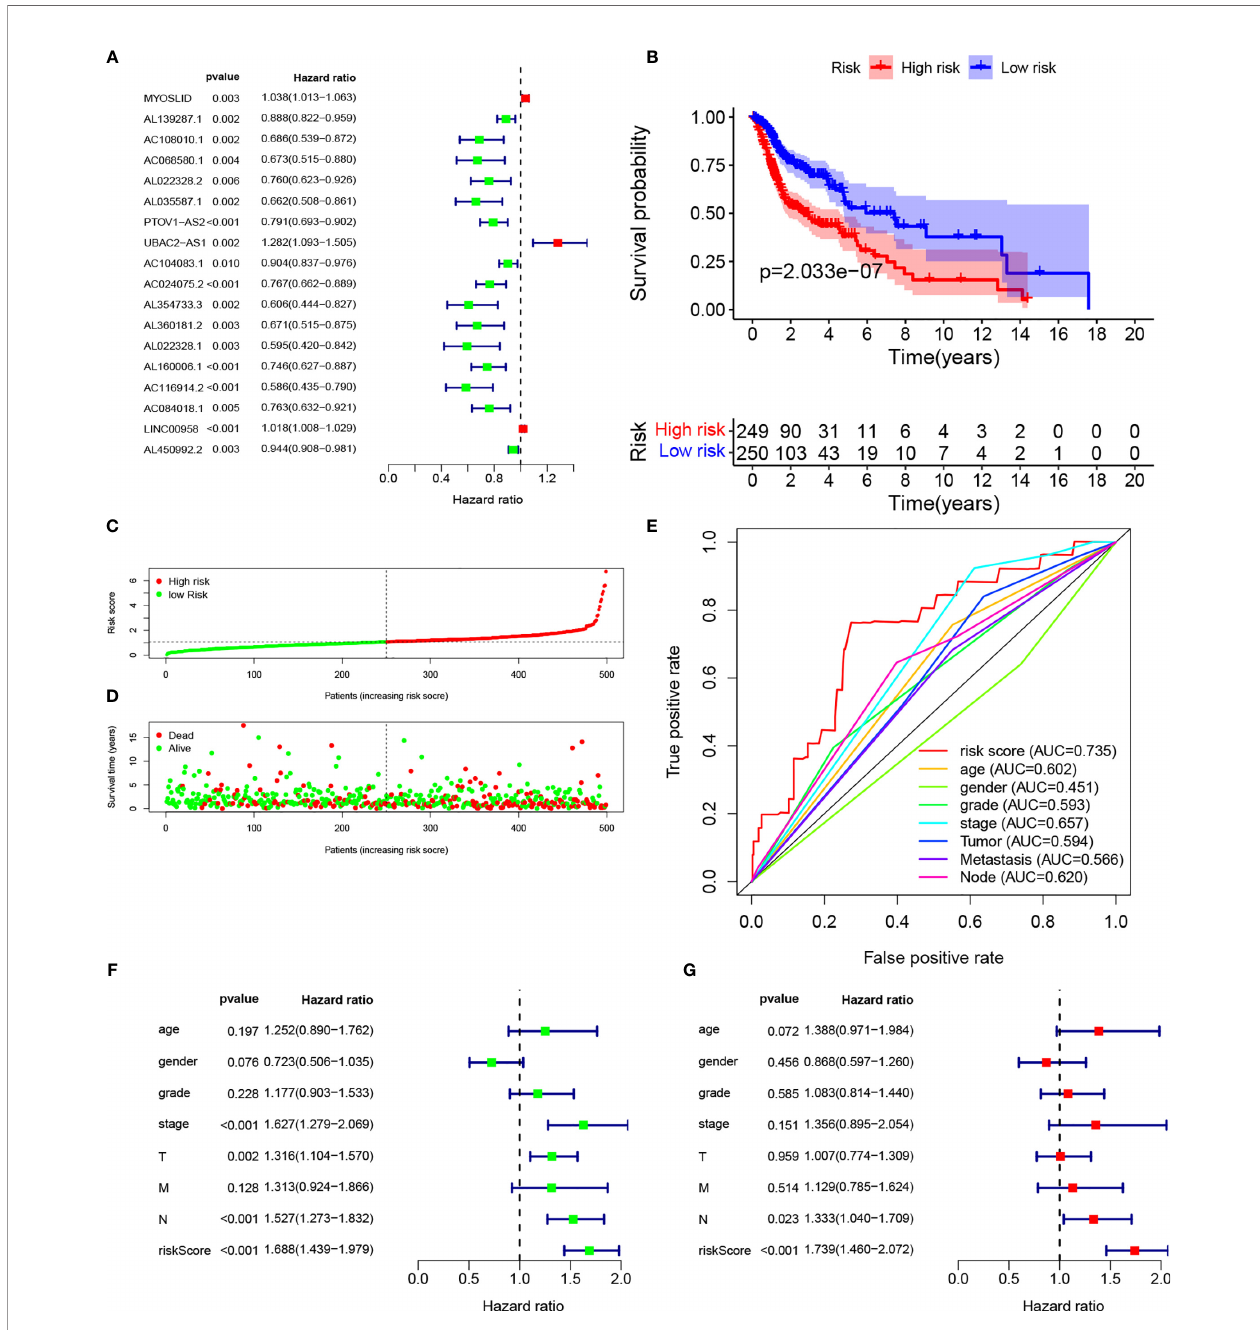
FIGURE 1 | Establishment of autophagy-related lncRNA signature for HNSCC patients. (A) Forest plot of univariate Cox regression for autophagic lncRNAs correlated with HNSCC prognosis. (B) Kaplan – Meier curves of overall survival for high- and low-risk groups. (C) Risk scores of the high- and low-risk groups. (D) Scatterplot of risk scores and survival time/survival outcomes. (E) ROC curves of prognostic signature and other clinical parameters. (F, G) Forest plots of univariate and multivariate Cox regressions, respectively, for association between risk score and overall